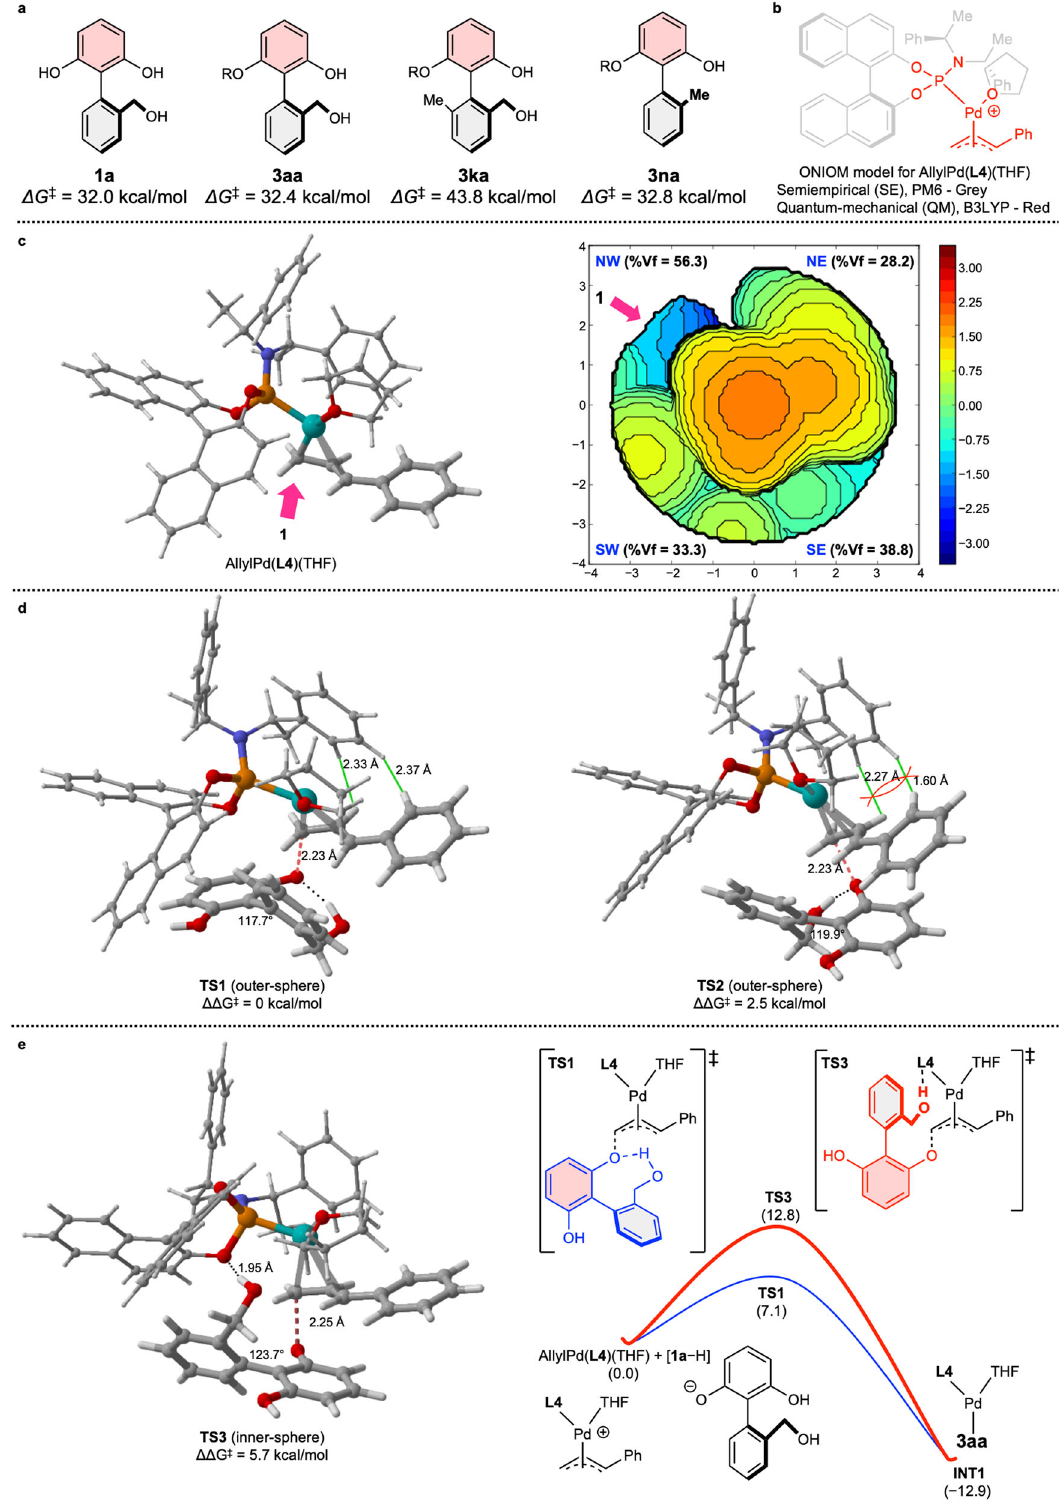
Fig. 5 Computational studies. a Computed barriers to rotation about the C – C bond. b ONIOM model for AllylPd( L4 )(THF). c Optimized geometry of the AllylPd( L4 )(THF) complex and steric map. d Transition state structures of the outer-sphere models and computed relative energy pro fi les. e A transition state structure of the inner-sphere model and computed relative energy pro fi